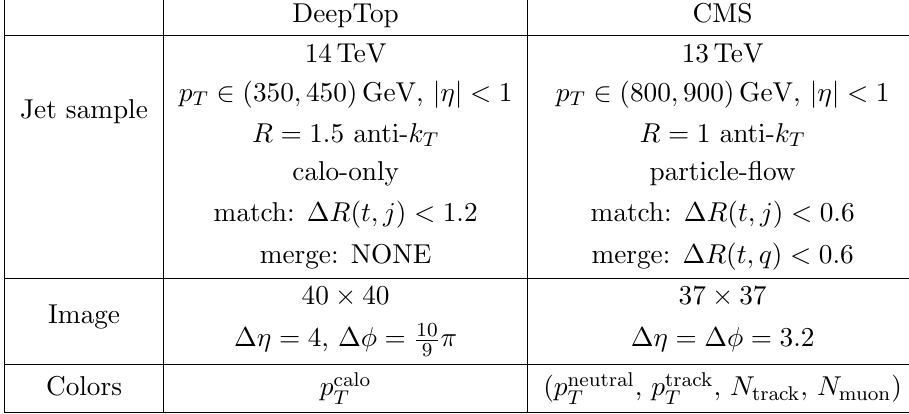
Table 1 . The two jet image samples used in this